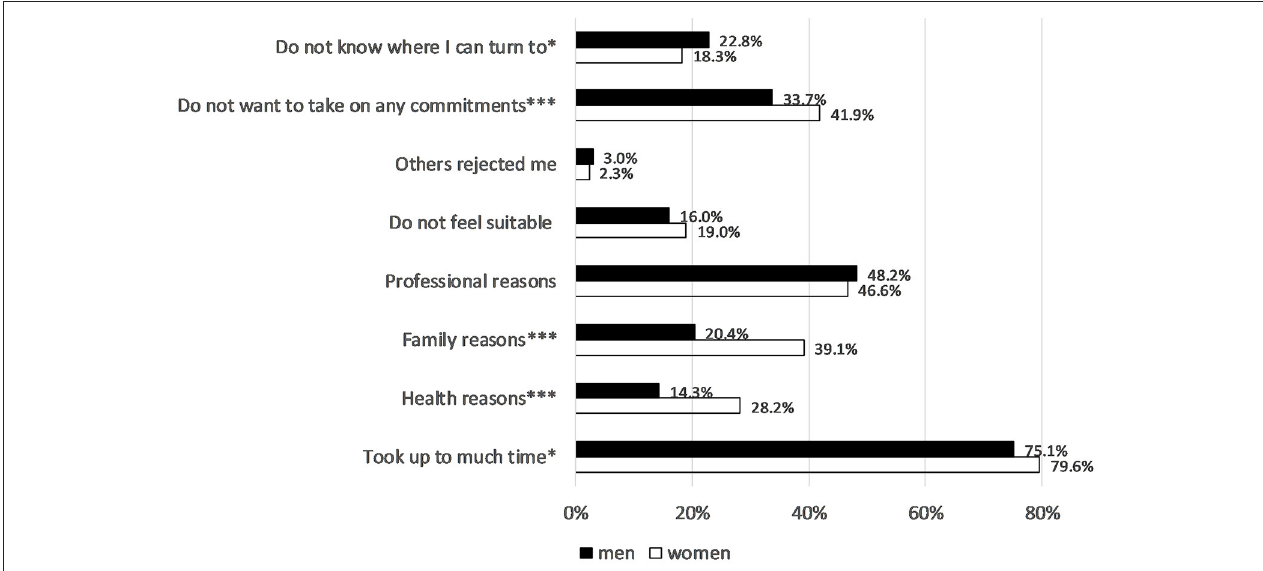
FIGURE 3 | Reasons for not volunteering in 2019. Approval ratings in %, gender differences using Chi 2 test: * p < 0.05, ** p < 0.01, *** p < 0.001. German Survey on Volunteering (FWS).